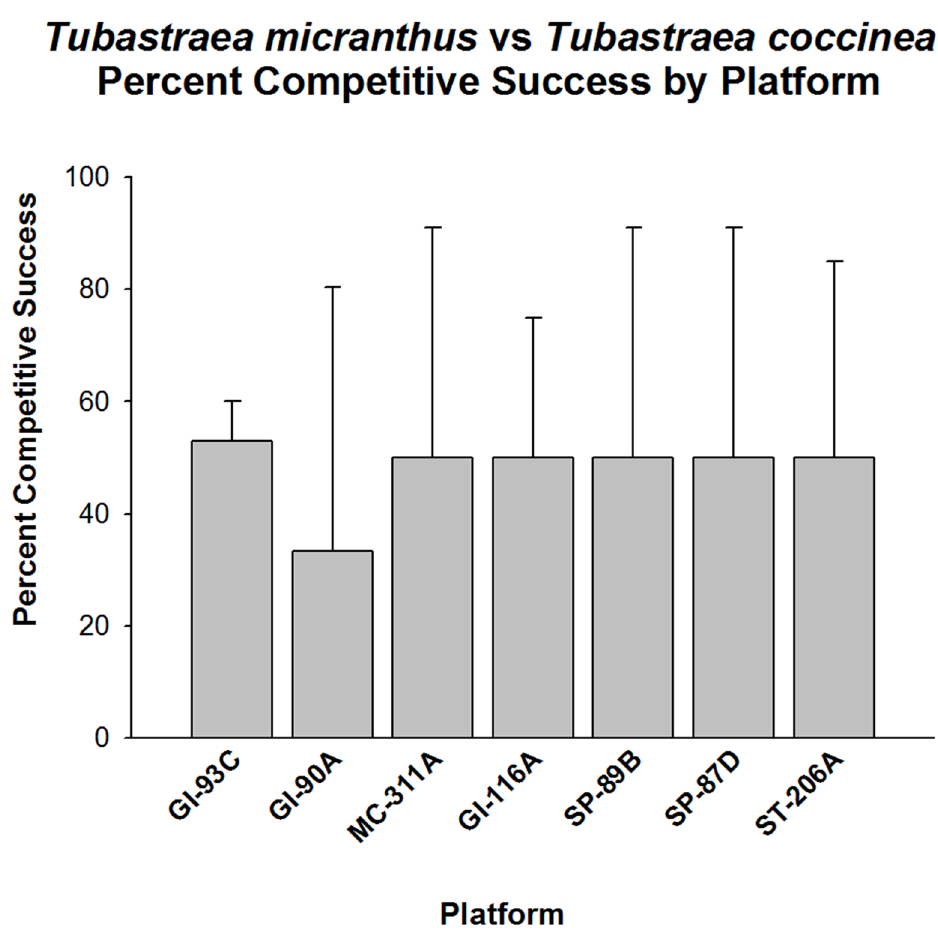
Fig 4. Percent success in competition for space between Tubastraea micranthus vs. T . coccinea . Here, the former species is the target organism. Presented by platform. Mean plus 95% confidence limits shown. See Fig 2 legend for additional details. No significant difference in overall competitive success (p > 0.05, Fisher ’ s Exact